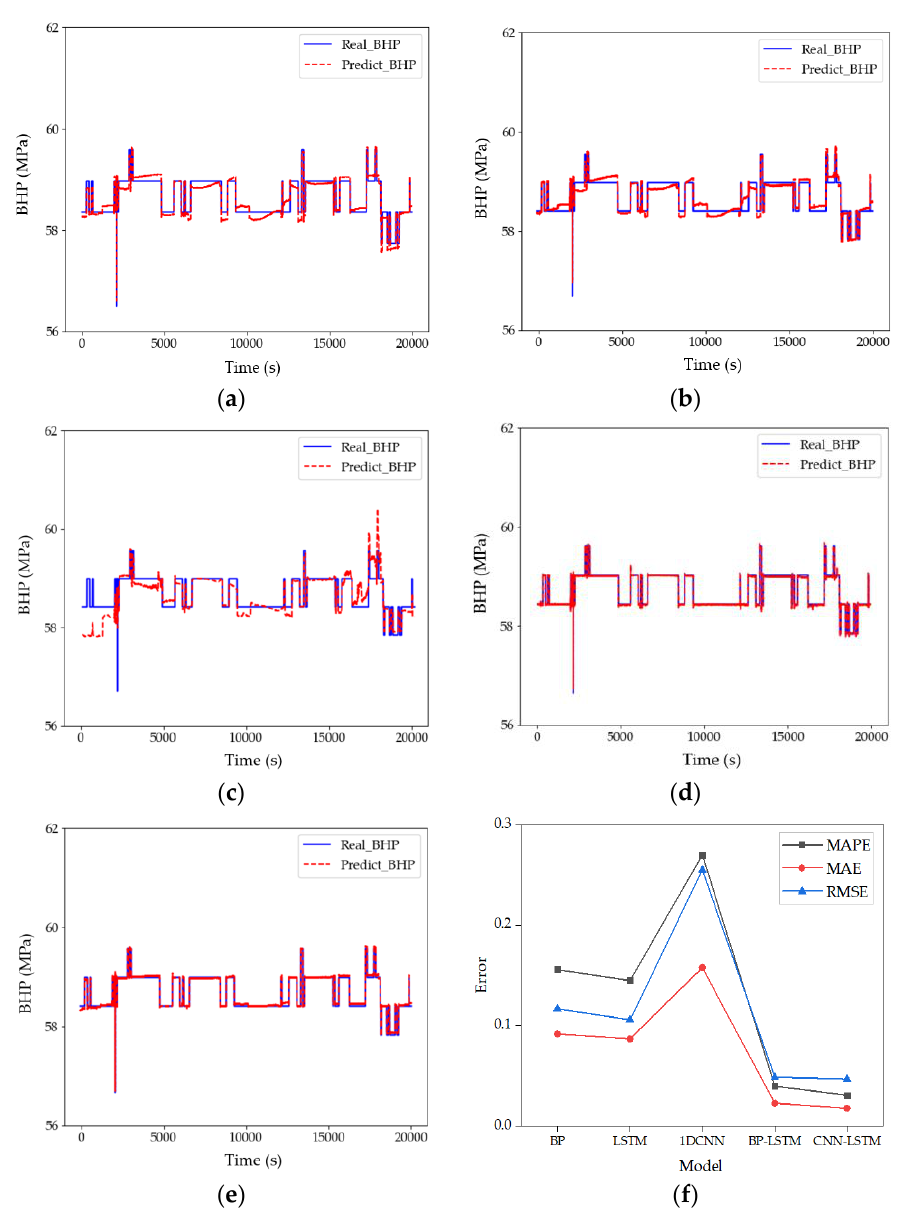
Figure 9. Comparison and evaluation results of real and predicted BHP. ( a ) The prediction results of BP network; ( b ) The prediction results of LSTM network; ( c ) The prediction results of 1DCNN; ( d ) The prediction results of BP-LSTM parallel network; ( e ) The prediction results of CNN-LSTM parallel network; ( f ) Performance evaluation results of various